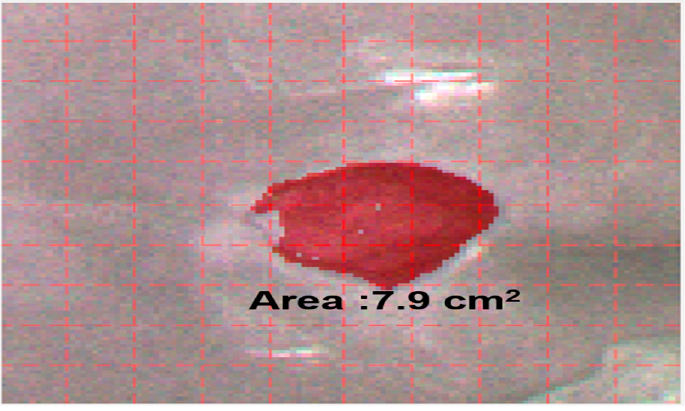
Figure 3. Coccyx sacral pressure injury with an area of 7.9 cm2.